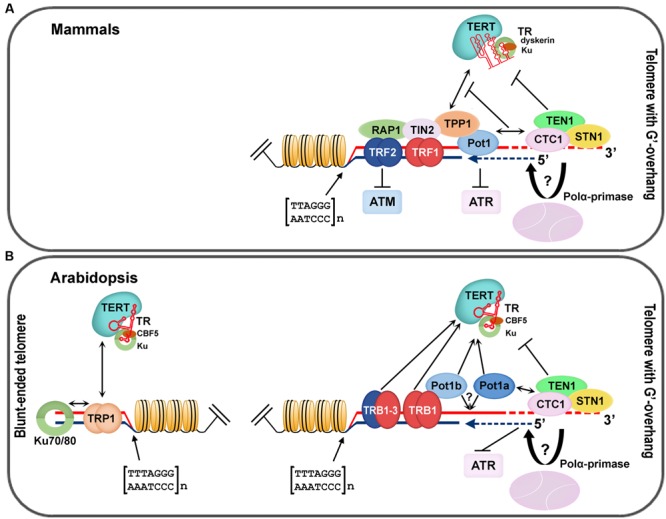
Nucleoprotein complexes associated with mammalian and A. thaliana telomeres. (A) Mammalian shelterin proteins (TRF1/2, Rap1, TIN2, TPP, and Pot1) modulate access to the telomerase complex and the ATR/ATM dependent DNA damage response pathway. The CST complex (CTC1–STN1–TEN1) affects telomerase and DNA polymerase α recruitment to the chromosomal termini, and thus coordinates G-overhang extension by telomerase with fill-in synthesis of the complementary C-strand (blue dashed line; figure adopted from Chen and Lingner, 2013). (B)
Arabidopsis TRB1, 2 and 3 interact with the telomeric sequence due to the same Myb-like binding domain as mammalian TRF1/2 (Marian et al., 2003; Kuchar and Fajkus, 2004; Schrumpfova et al., 2004). TRB proteins interact with TERT and Pot1b and when localized at chromosomal ends they are eligible to function as components of the plant shelterin complex, mainly at telomeres with a G-overhang (Schrumpfova et al., 2008, 2014). An evolutionary conserved CST complex is suggested to coordinate the unique requirements for efficient replication of telomeric DNA in plants as well as in other organisms (Derboven et al., 2014). Blunt-ended telomeres are specifically recognized and protected by the KU70/80 heterodimer that directly interacts with TRP1, and by extension, with TERT (Kuchar and Fajkus, 2004; Kazda et al., 2012; Schrumpfova et al., 2014).